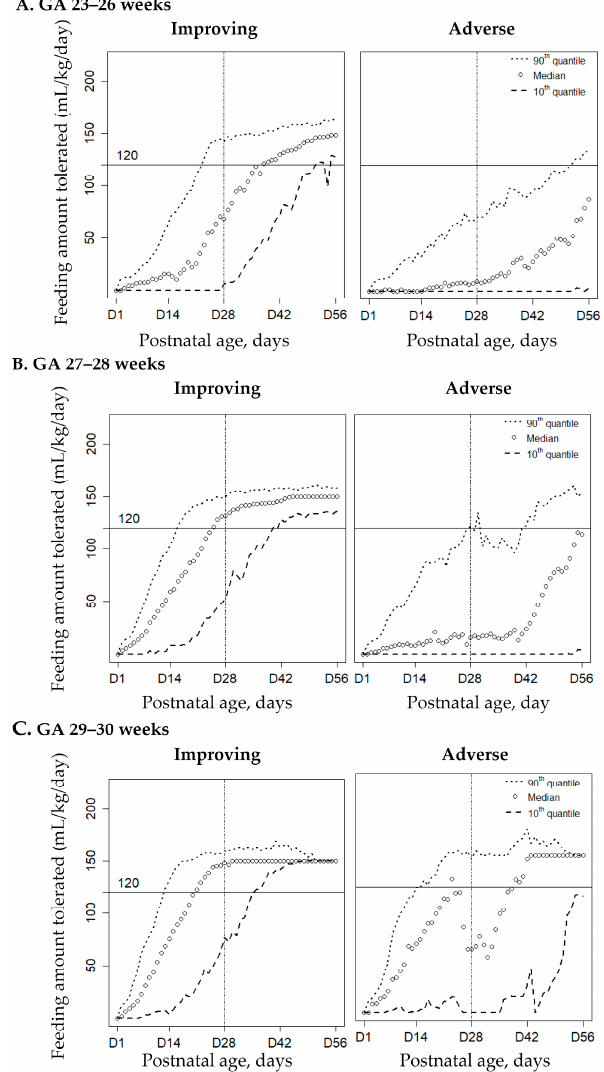
Figure 1. The kmlShape clustering analysis characterizes the feeding trajectories based on the daily median volume of enteral intake (mL/kg/day) in the first 56 postnatal days as improving, and adverse patterns in infants at gestational age (GA) of 23–26 weeks ( n = 183) ( A ), 27–28 weeks ( n = 215) ( B ), and GA 29–30 weeks ( n = 227) ( C ). The trajectory data are presented as the median and the 90th and 10th quantiles, and full feeding is defined as reaching 120 mL/kg/day.